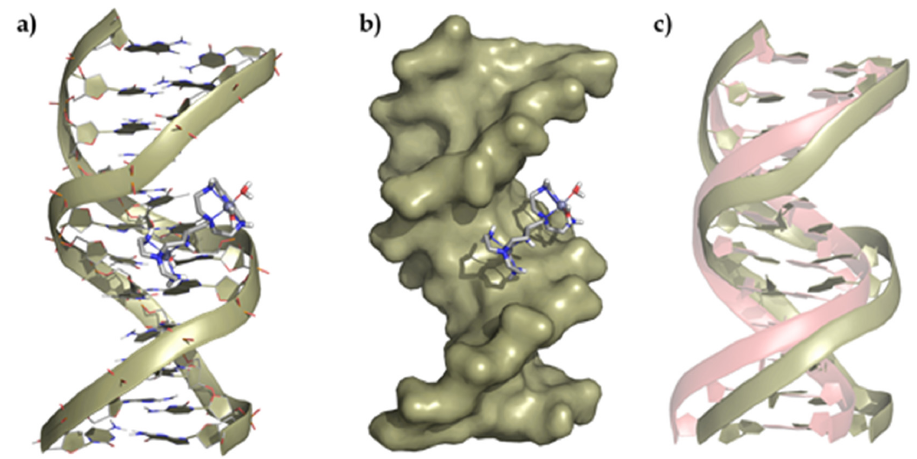
Figure 8. Representation of ( a ) the interaction of Zn 2 L1 4+ with the ds-DNA model, ( b ) the polynucleotide surface, and ( c ) deviation of the ds-DNA structure after interaction regarding its original conformation (represented in red).